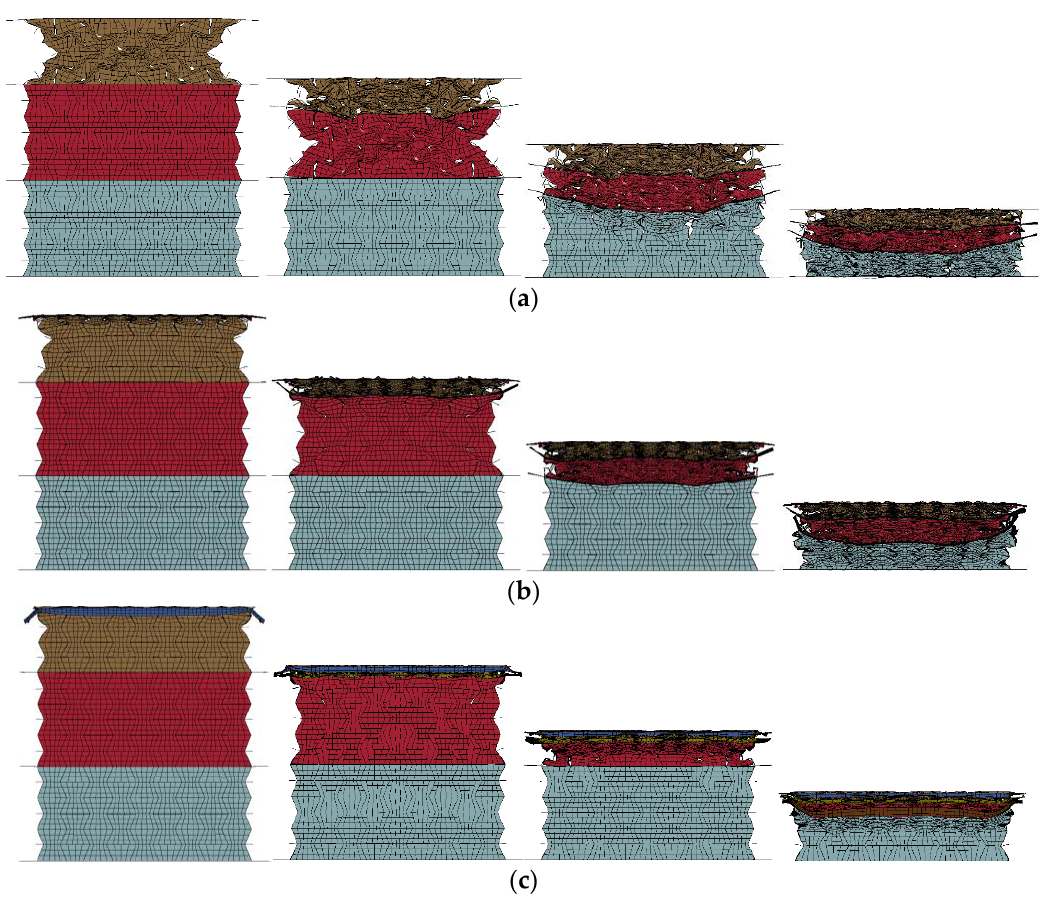
Figure 23. The response modes of the composite ( t = 0.4:0.4:0.4 and ρ = 408:575:848): ( a ) quasi-static mode (1 m/s); ( b ) transitional mode (10 m/s); ( c ) progressive collapse mode (100 m/s).